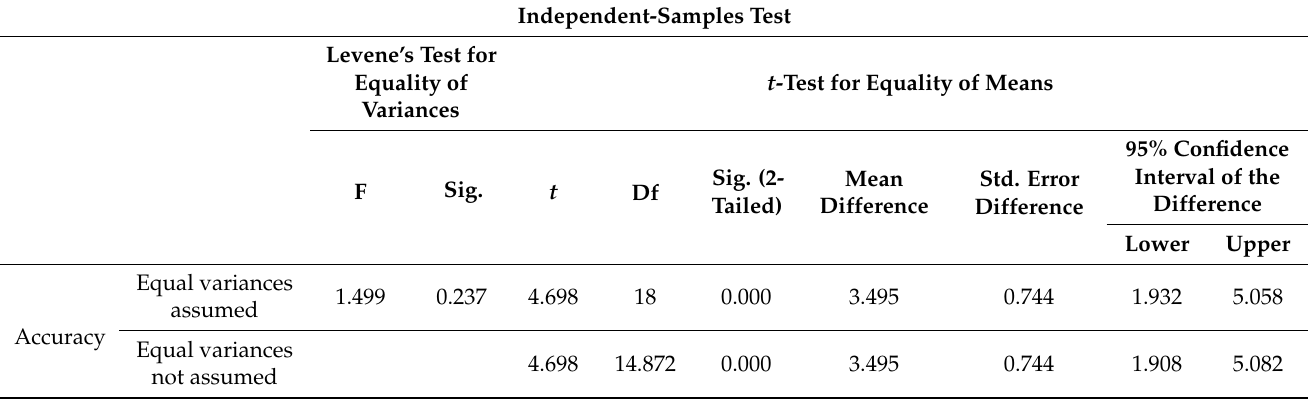
Table 5. Independent-sample test significance computation between ECNN and CNN algorithms for accuracy.